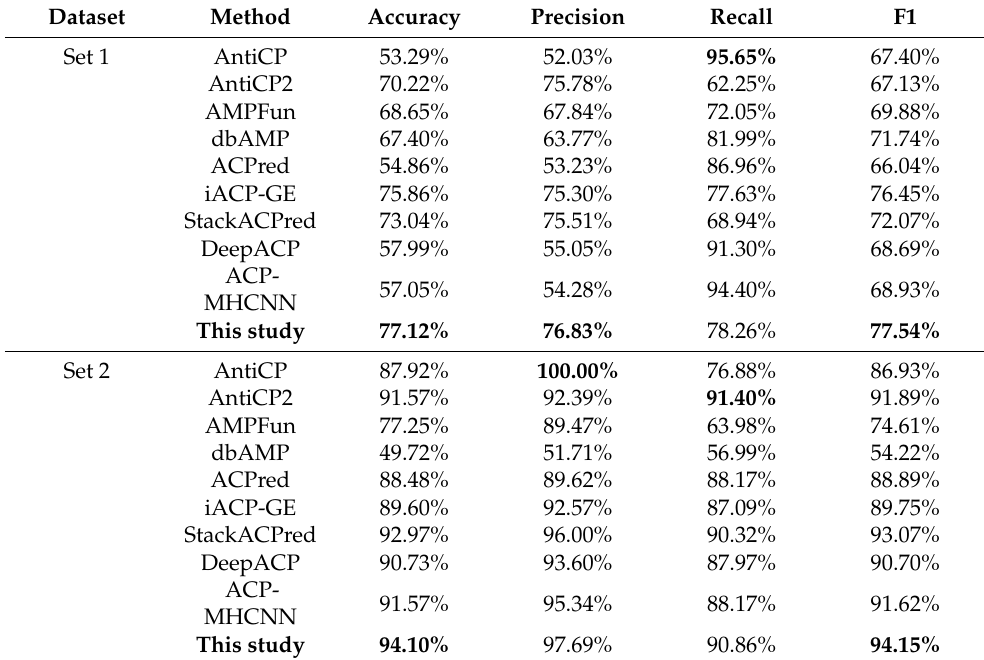
Table 1. Performance comparison with the other ACP prediction models proposed in recent years on independent test sets. Best performance values are in